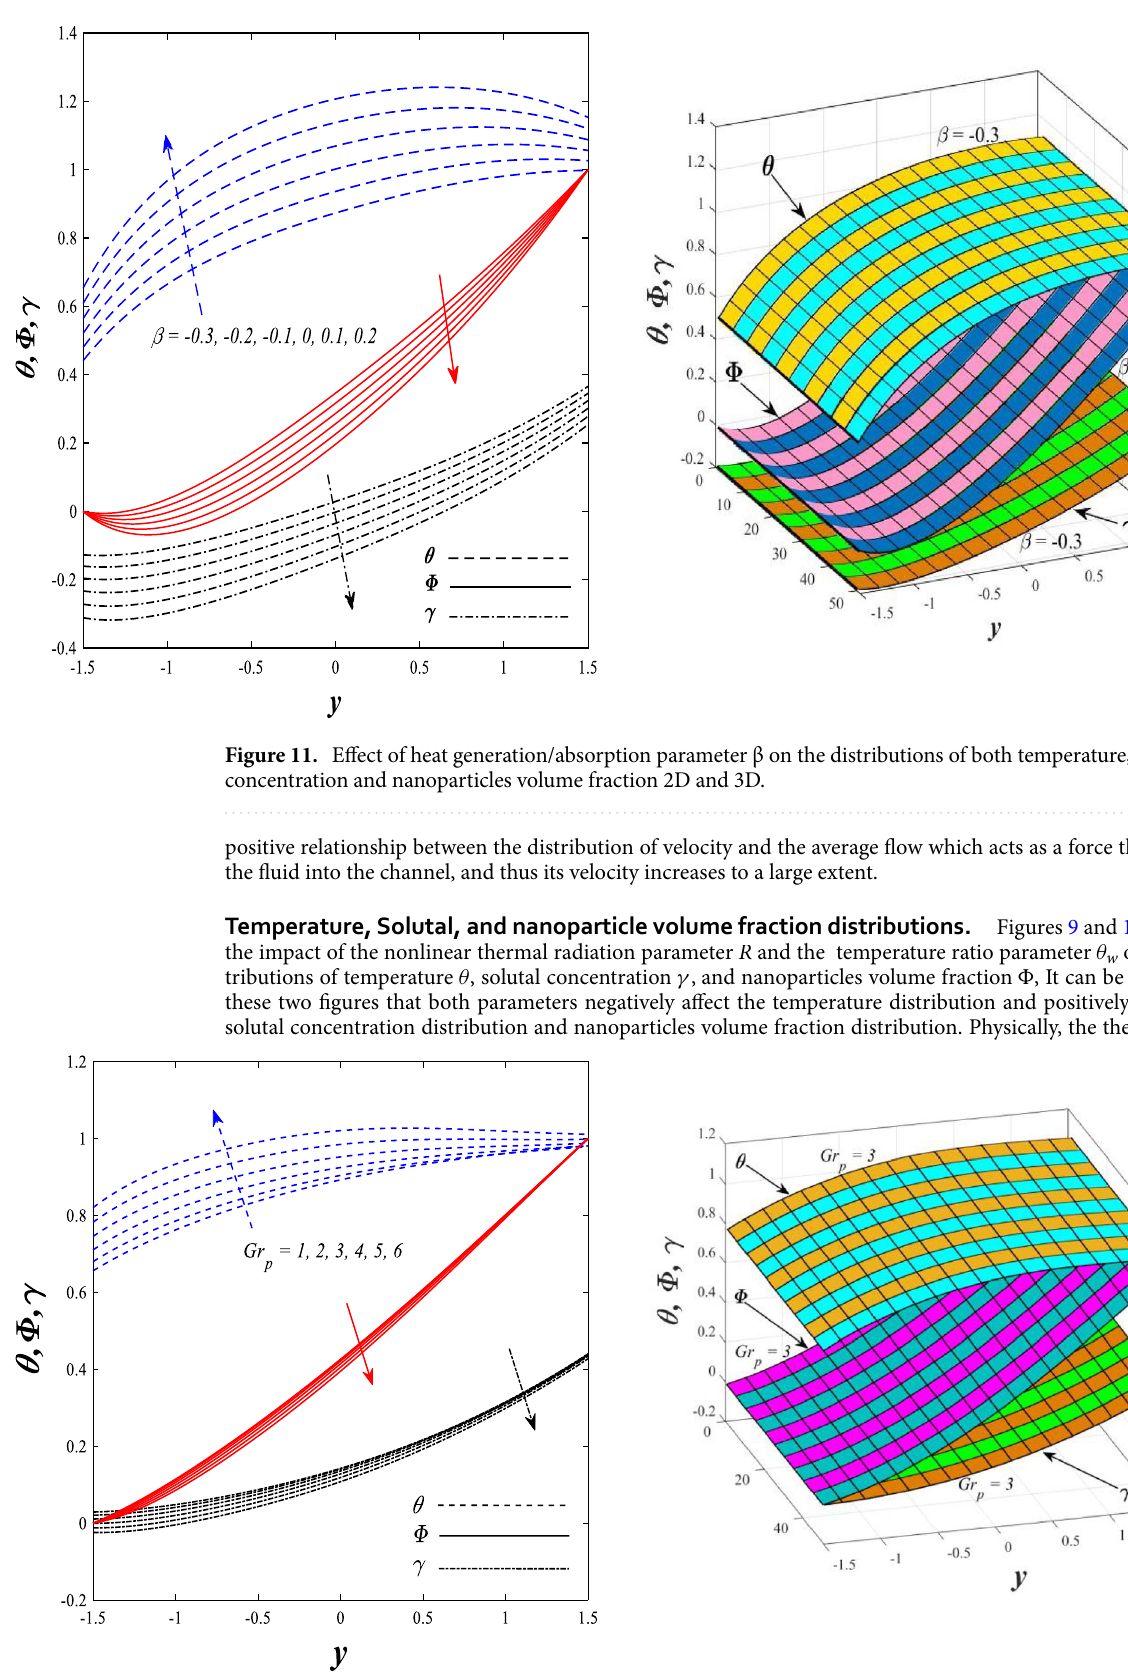
Figure 12. Effect of nanoparticles Grashof number Gr p on the distributions of both temperature, solutal concentration and nanoparticles volume fraction 2D and